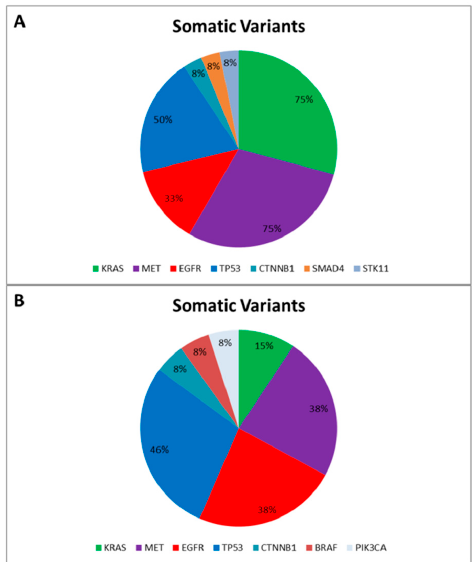
Figure 1. Somatic Variants identified in the “Training Set” ( A ) and in the “Validation Set” ( B ), respectively. The pie charts report the frequency of mutated genes in the “Training Set” ( A ) and